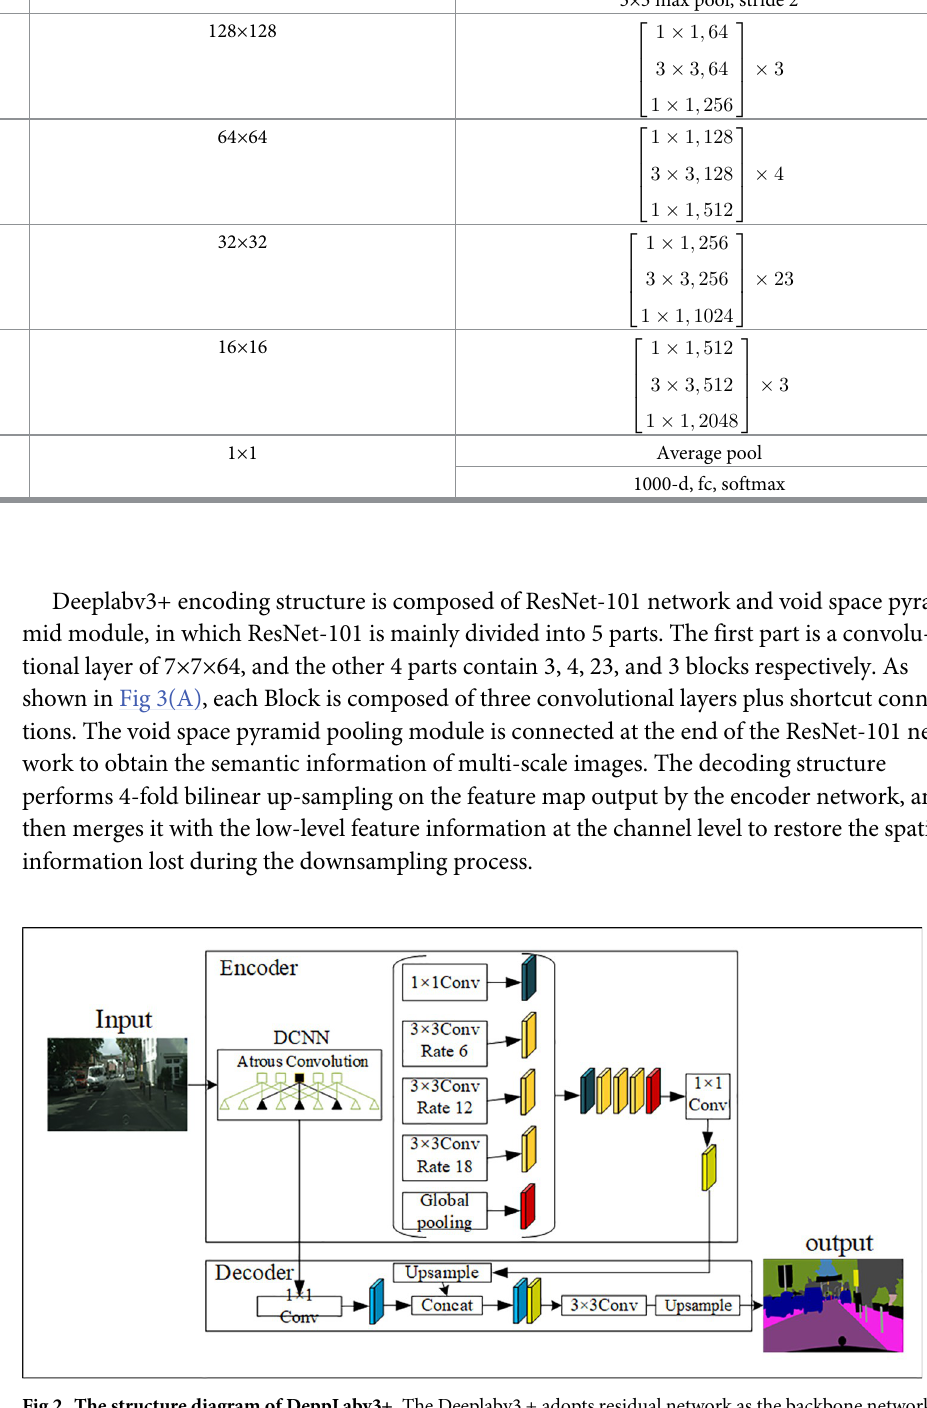
Fig 2. The structure diagram of DeppLabv3+. The Deeplabv3 + adopts residual network as the backbone network, and uses encoding and decoding structure to improve semantic segmentation effect [18].